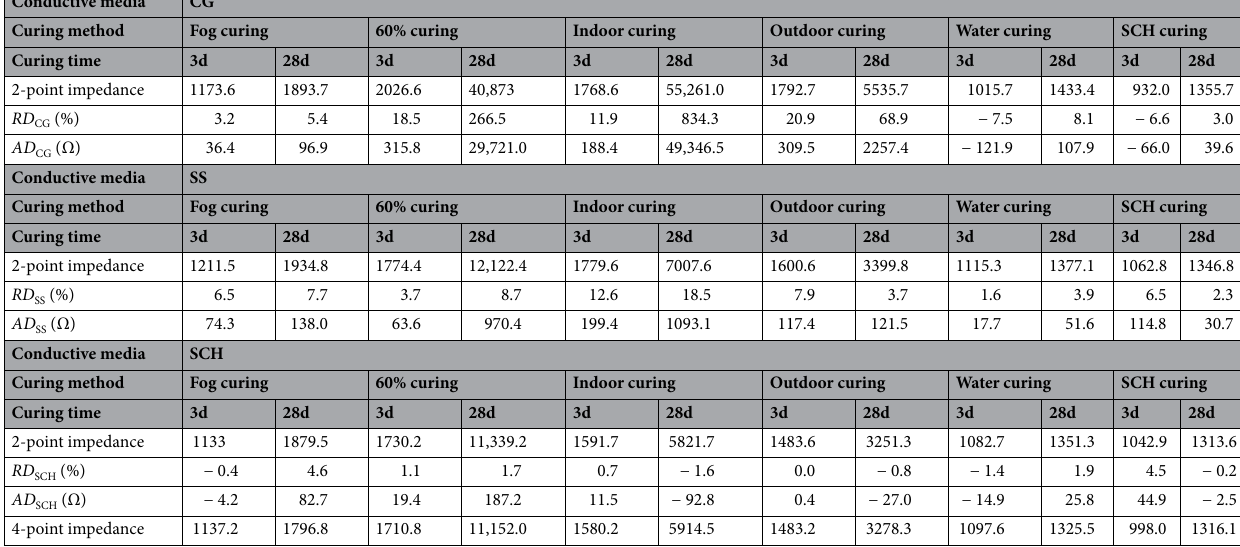
Table 5. Relative deviation of sample impedance measured by the two- and four-point measurements under different curing conditions. RD CG , RD SS and RD SCH mean the relative deviation of contact impedance evaluated by the two-point measurement with different conductive media to the four-point measurement impedance (true sample impedance). AD CG , AD SS and AD SCH mean the absolute deviation of contact impedance measured by the two-point measurement with different conductive media versus the four-point measurement impedance (true sample impedance).